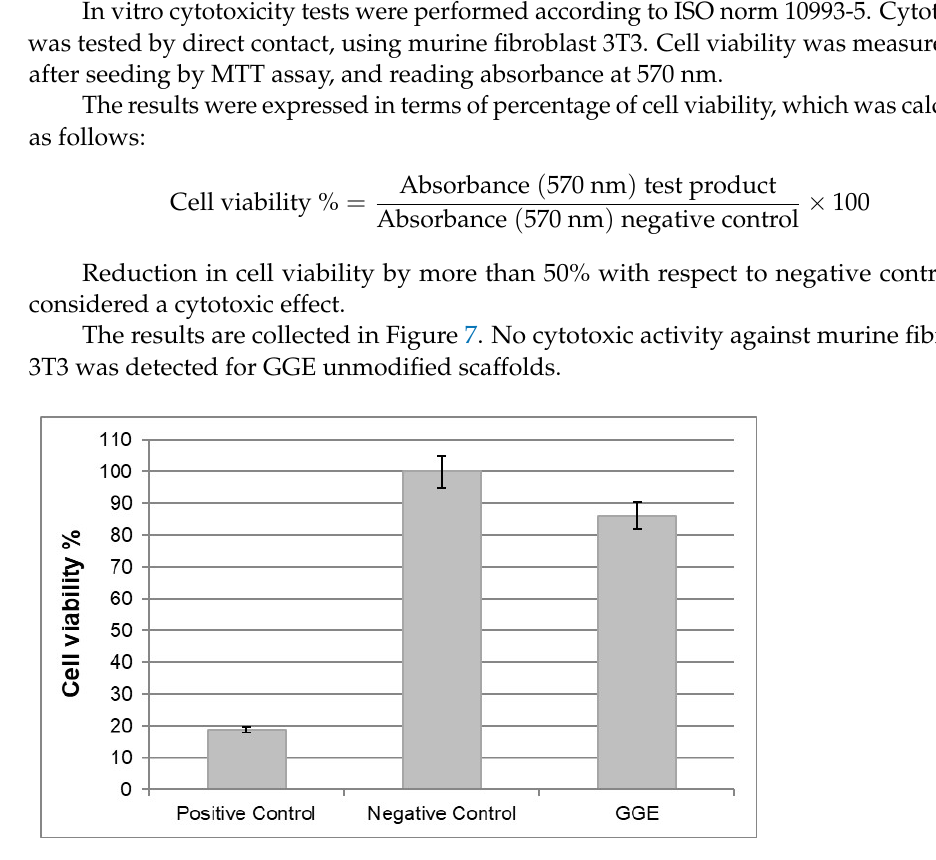
Figure 7. Results of cytotoxicity test on GGE scaffolds.